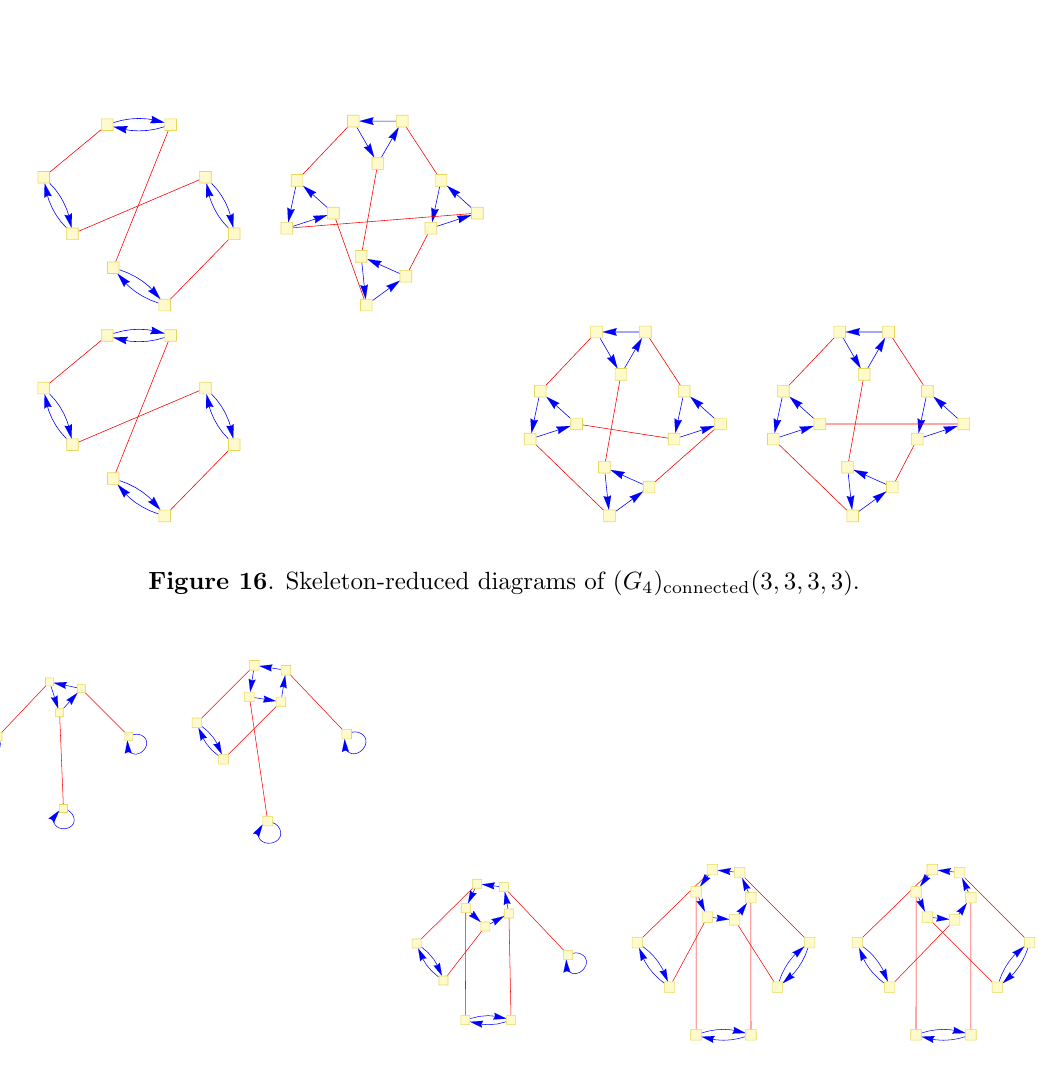
Figure 17 . Skeleton-reduced diagrams of ( G 4 ) connected (6 ; 2 ; 2 ; 2).